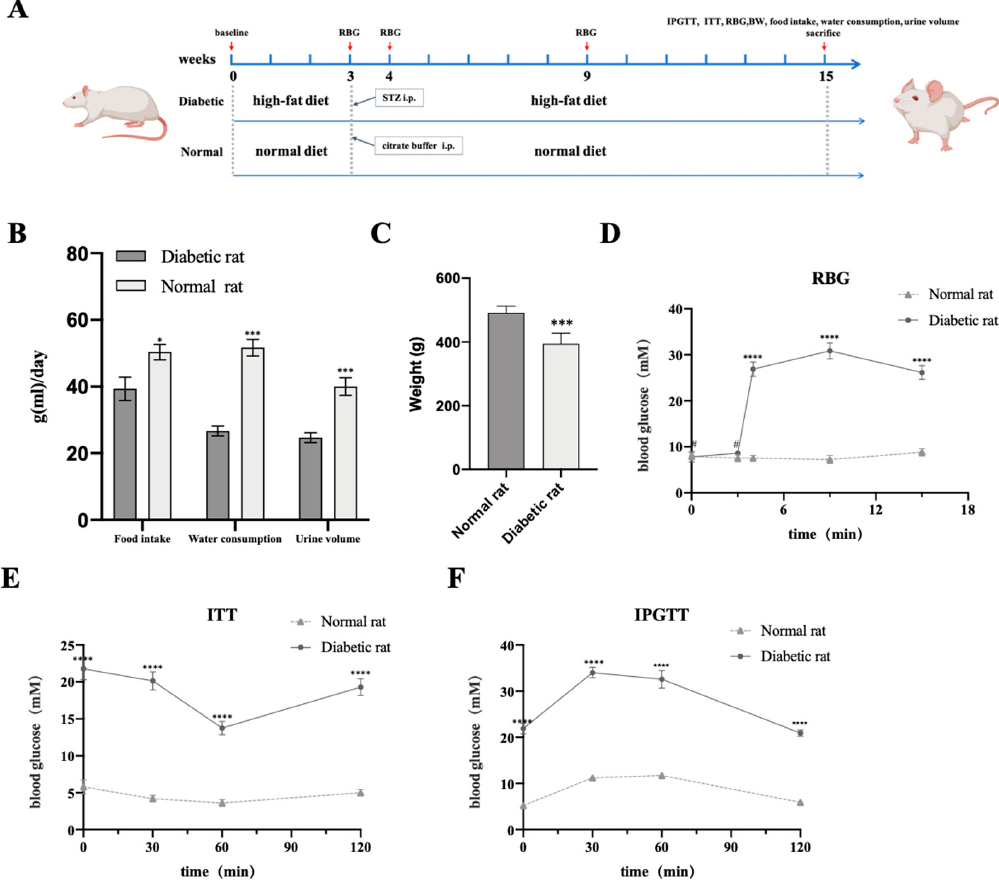
Figure 3. Assessment of T2DM rat models. ( A ) Procedure of animal operations. ( B , C ) Food intake, water consumption, urine volume and body weight (BW) of two groups at 12 weeks after STZ in- jection. ( D ) RBG at several special time points before fed HFD, before STZ injection, one week after STZ injection, 6 weeks after STZ injection and 12 weeks after STZ injection. ( E , F ) Blood glucose levels during ITT and IPGTT in two groups at 12 weeks after STZ injection. Data are presented as the mean ± SD ( n = 18, per group). * p < 0.05, *** p < 0.001, **** p < 0.0001, # p > 0.05.